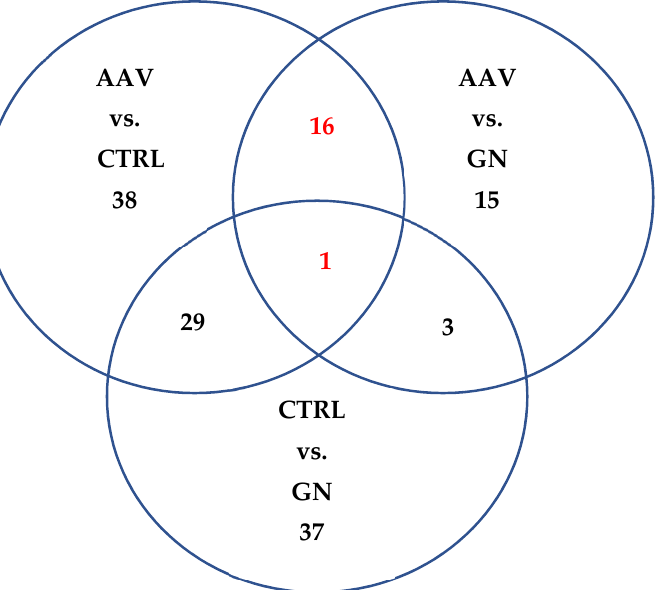
Figure 2. Venn diagram of the number of statistically significant differentially expressed miRNAs. Legend: AAV, ANCA-associated vasculitis; CTRL, subjects without clinical presentation of renal disease; GN, patients with glomerulonephrites other than AAV.